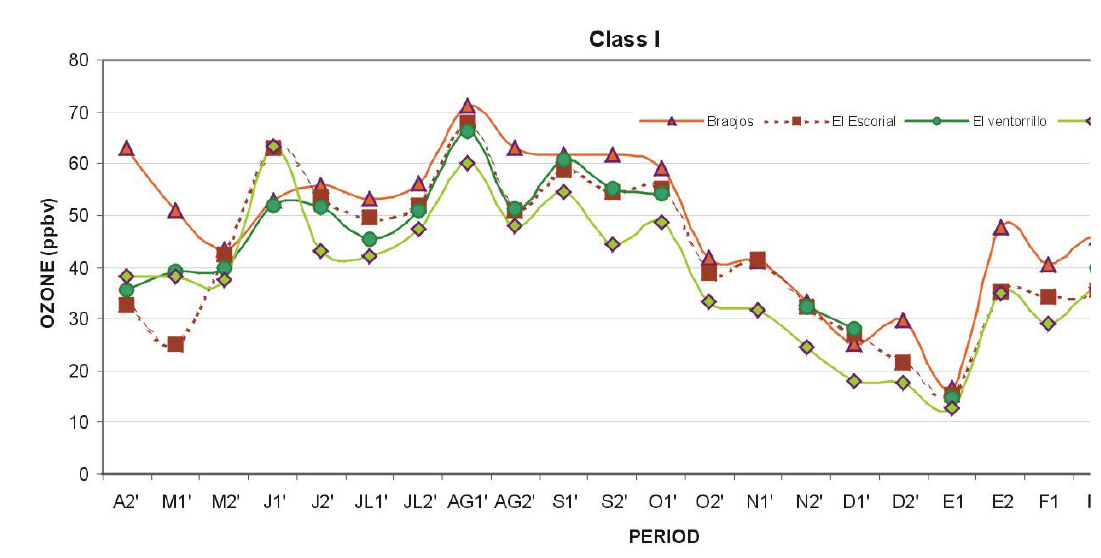
FIGURE 3. Ozone 2-week averages (ppbv) for all Class I locations from mid-April 2000 (April 2) to end of March 2001 (March 2).